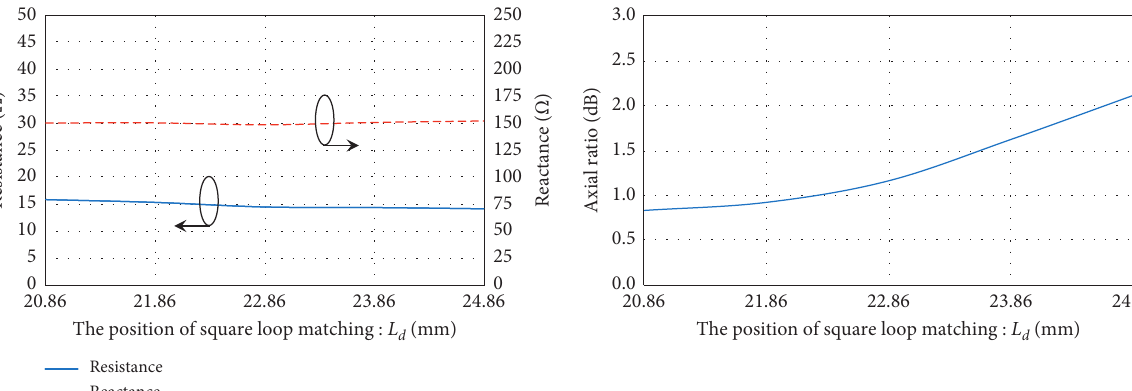
c , (b) L c , and (c) H c .